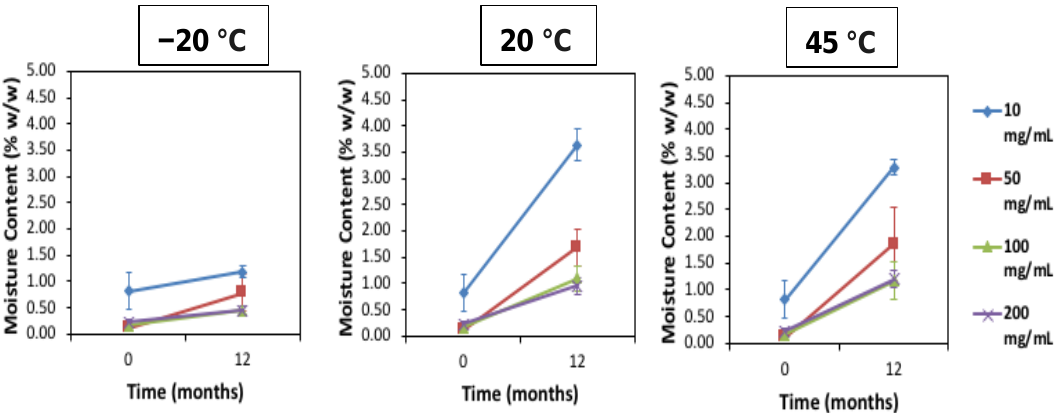
Figure 1. Average moisture content (%) for low to high concentration freeze-dried (FD) IgG before and after 12 months of storage at −20, 20 and 45 °C. Error bars are 95% confidence intervals ( n = 3 vial replicates).